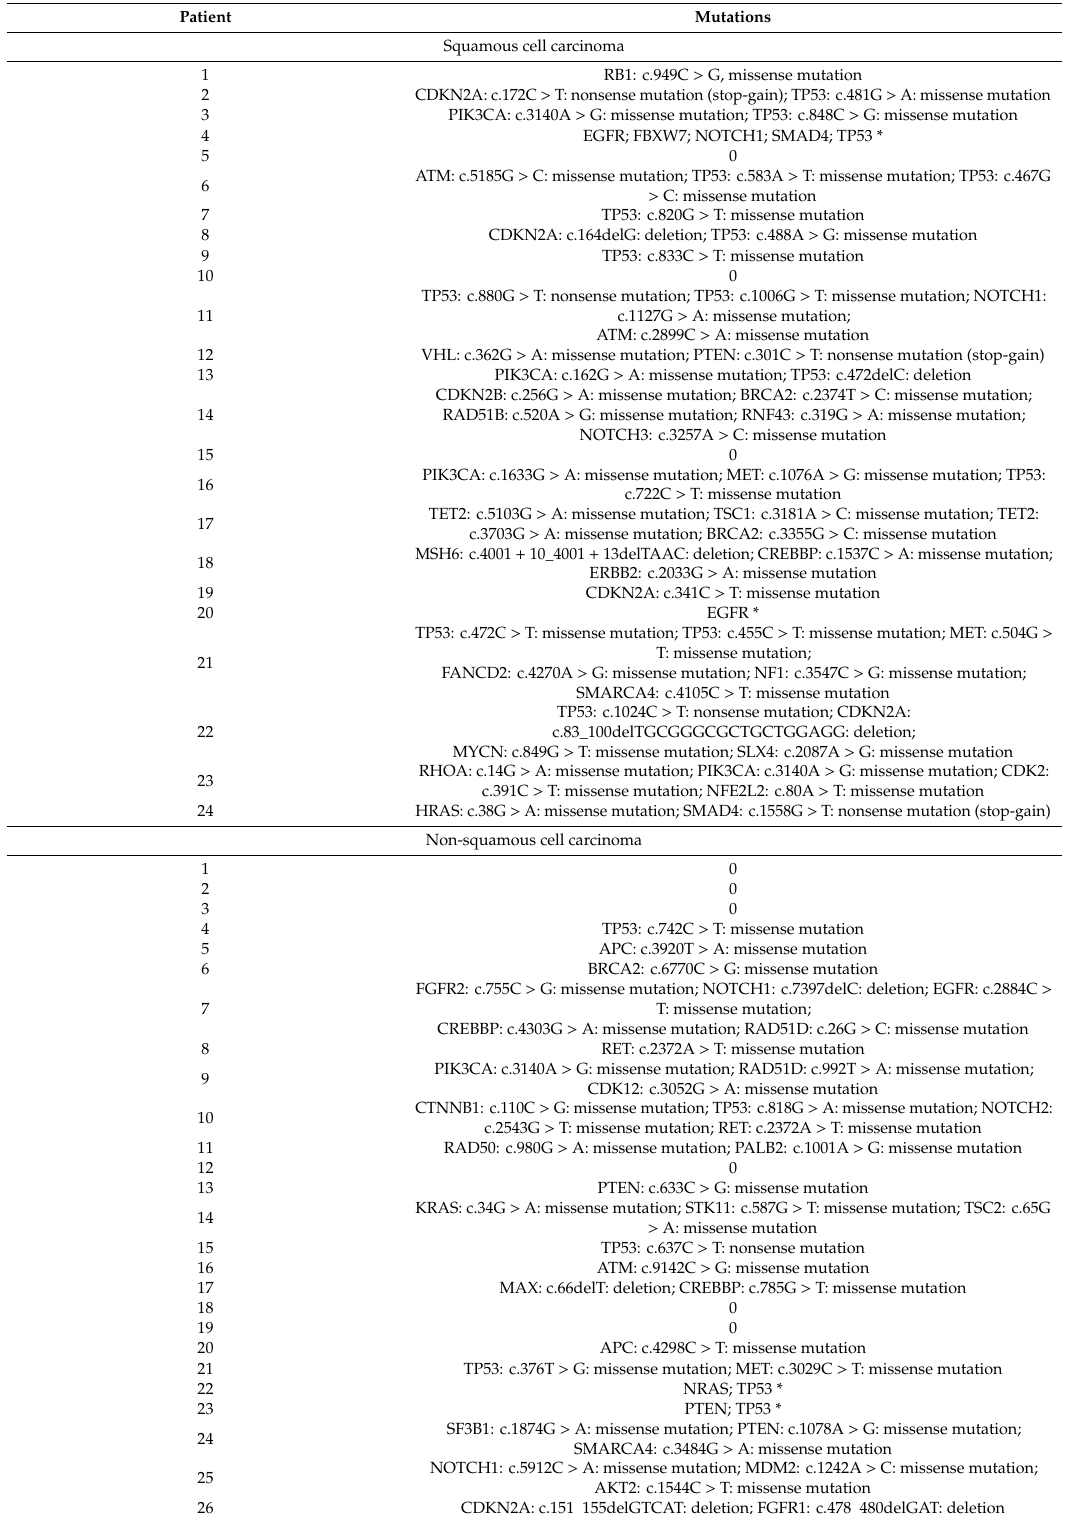
Table 3. Detailed information of mutations of each R / M HNC